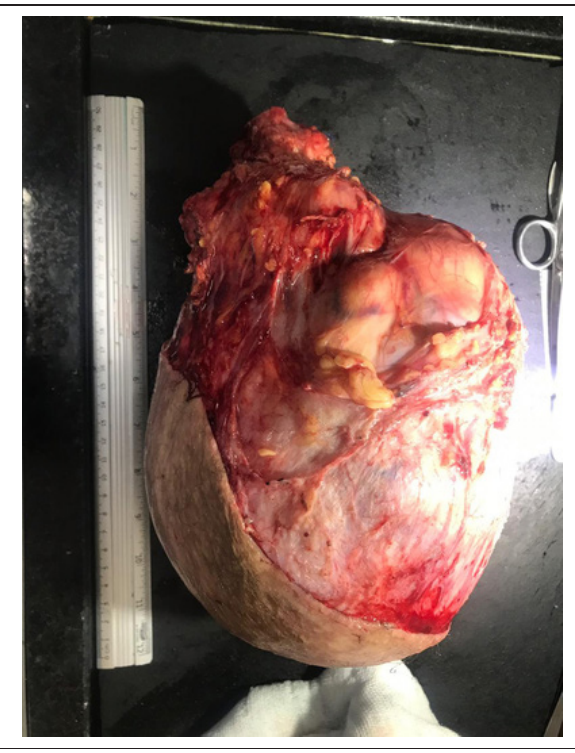
FIGURE 1 – Surgical specimen containing scrotum and left